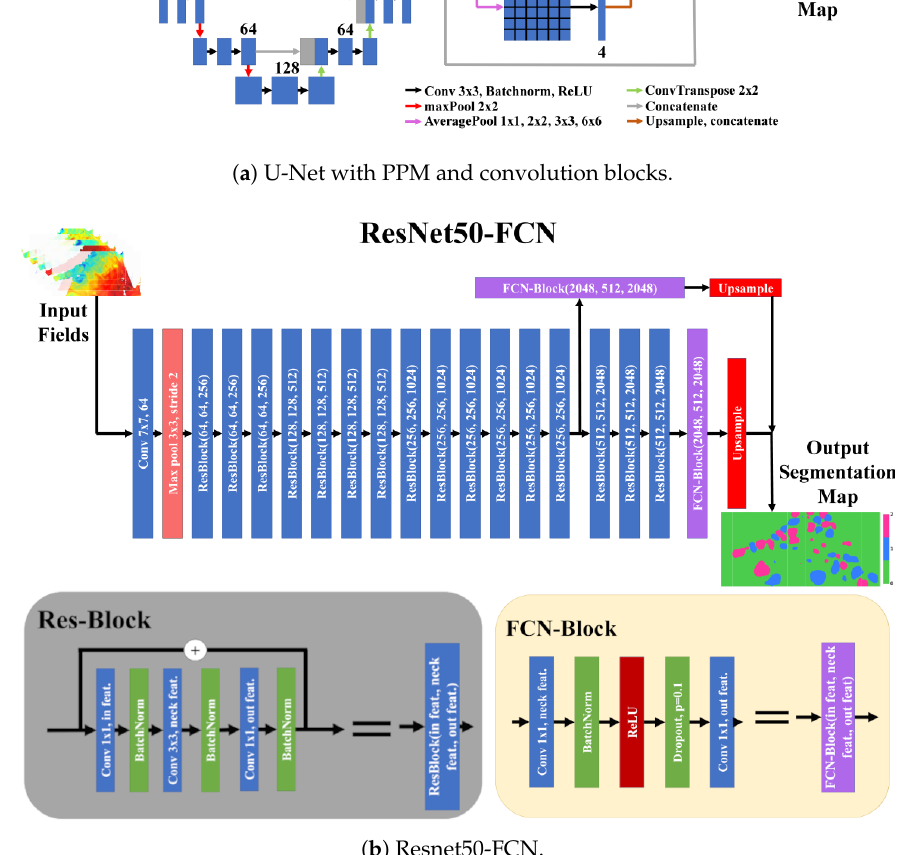
Figure 2. Neural − Network Architectures: Schematics of ( a ) the U-Net backbone with the PPM decode head, along with the Res- and FCN-blocks, and ( b ) the ResNet50–FCN that was pre-trained on a subset of the COCO dataset and is available in PyTorch’s torchvision. The deep neural network in ( a ) is trained by starting from randomized initial parameters, whereas that of ( b ) was trained from randomly initialized and pre-trained model parameters that are fine-tuned by training on the Arabian Sea